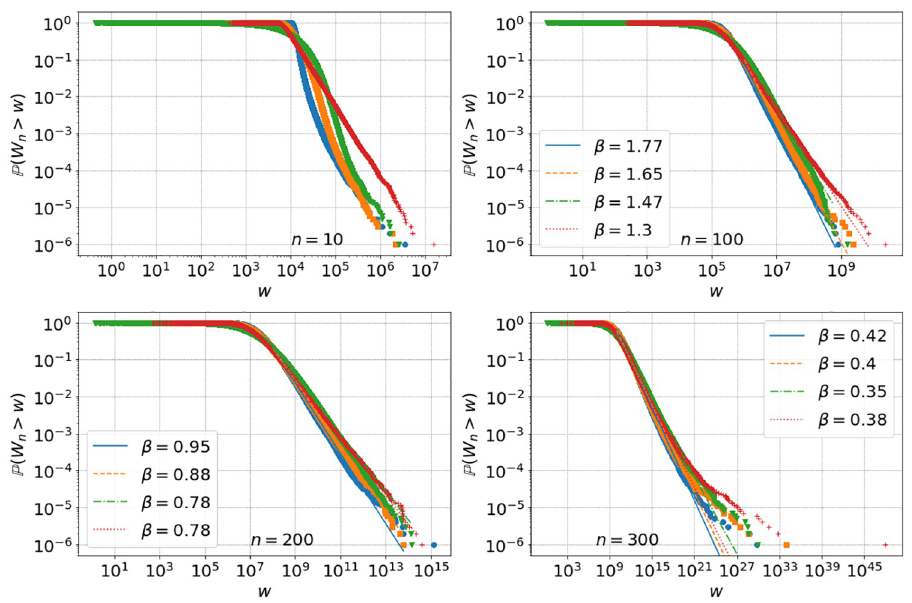
Fig 6. Empirical tails for simulation (3) with N = 10 6 agents, residual savings S n = 0, α n � nct( k , c , l , s ) with γ = 1.075, fitted parameters in (12), four initial conditions with colours and symbols as in I.1-I.4, and replacement mechanism R.1. Power law fits show heavier tails with exponents β decreasing with increasing times n = 10, 100, 200 and 300.